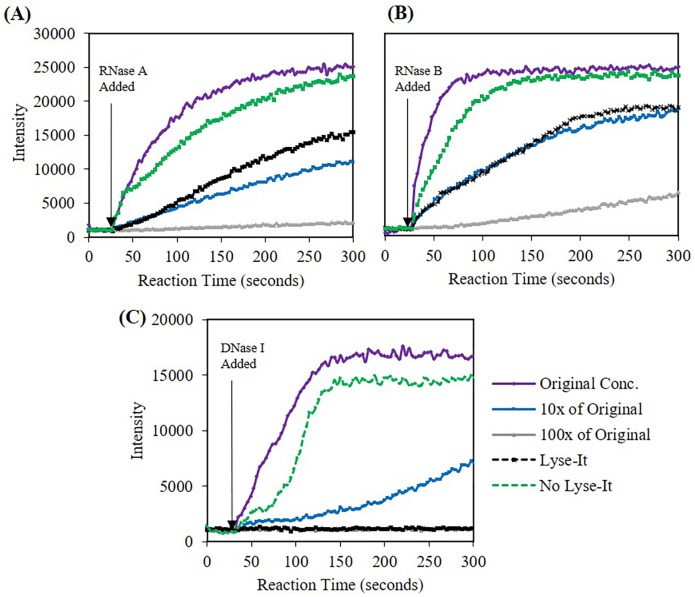
Fluorescent intensity at 520 nm (RNase A/B) and 556 nm (DNase I) versus time for nucleases in DI water lysed with and without Lyse-It at 50% power for 60 seconds.The concentration of lysing was undertaken with the highest concentration of nuclease. Each Pre was a 10-fold dilution from the starting concentration. (A) 20 pM starting RNase A (B) 46 pM starting RNase B, (C) starting 10.5 nM DNase I. When Lyse-It is used, the activity of the nuclease is significantly reduced as compared to without the use of Lyse-It.